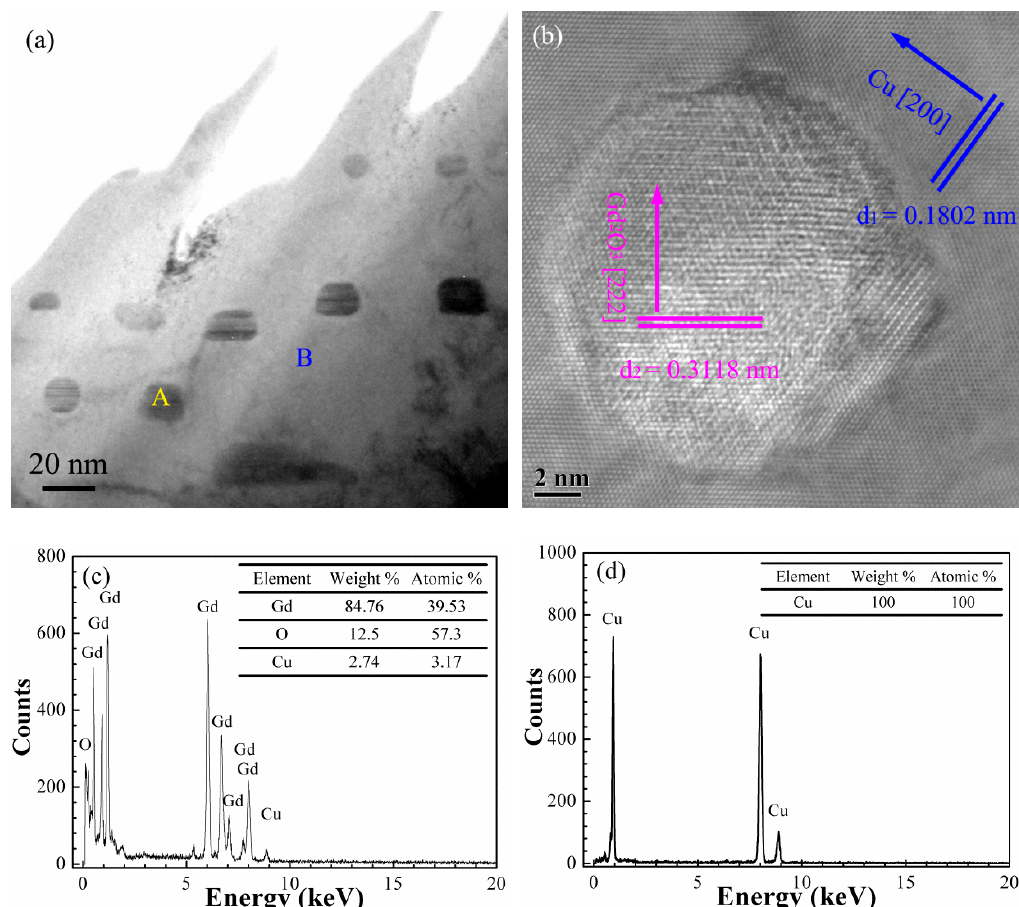
Figure 6. The TEM and EDS images of the Gd 2 O 3 /Cu composite: ( a ) bright field image; ( b ) high resolution image; ( c ) and ( d ) the corresponding EDS spectrum at areas A and B in Figure 6a re- spectively.